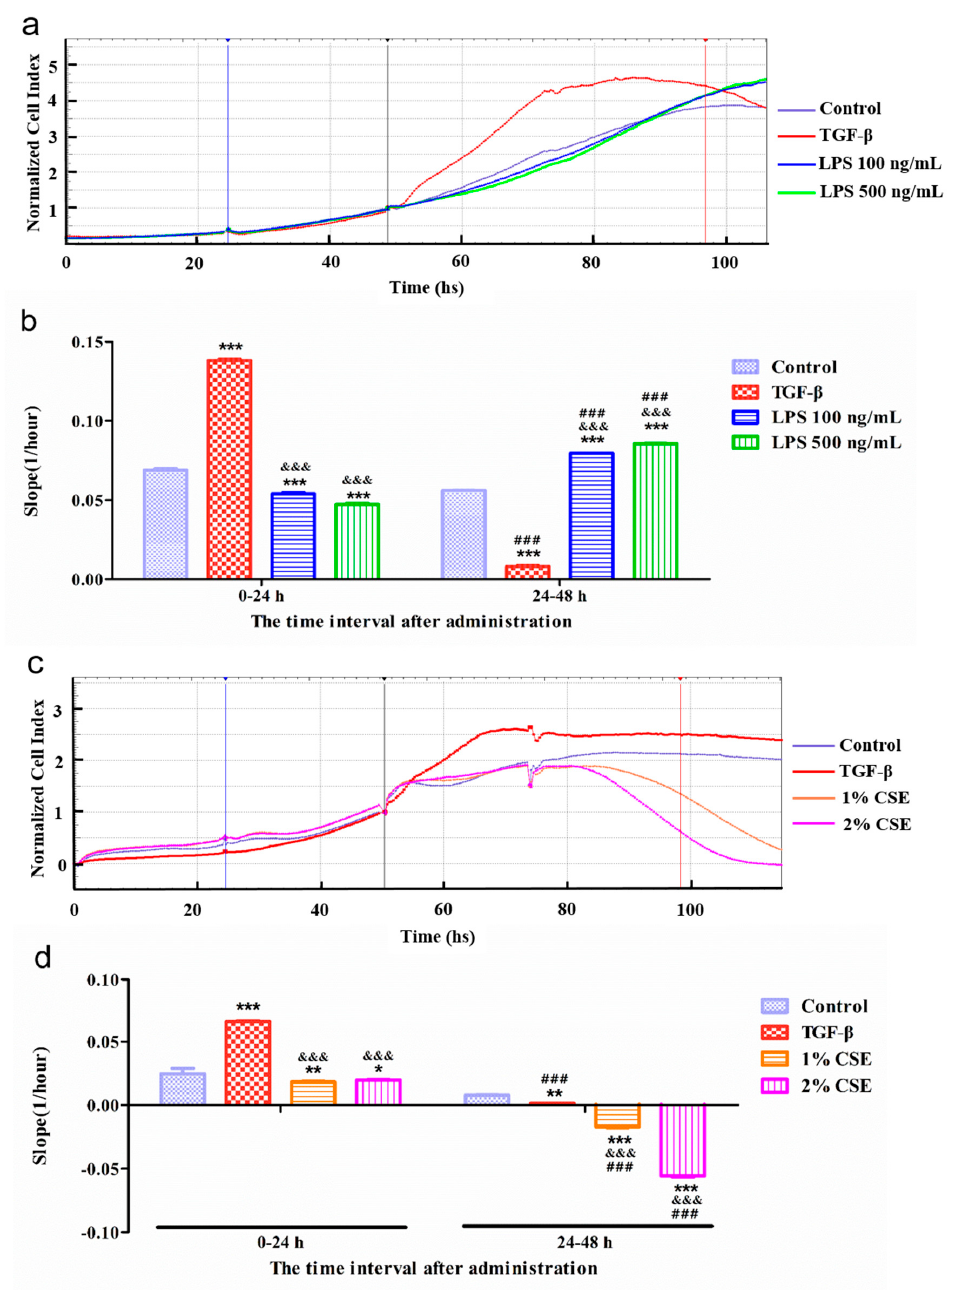
Figure 4. Real-time detection cell index of A549 with di ff erent treatments in the xCELLigence real-time cell analysis (RTCA) single-plate (SP) (RTCA SP) system. ( a ) A549 cells were treated with TGF- β and LPS (100 and 500 ng/mL). The serum starvation step for 24 h starts from the blue vertical line to the black vertical line in the timeline. The time interval between the black and red vertical lines represents administration for 48 h, and the black vertical line is the time to normalize the cell index. Representative curves of the normalized cell index. ( b ) The representative interval slope of the TGF- β and LPS groups. ( c ) A549 cells were treated with TGF- β and CSE (1% and 2%). The conditions were the same as above. ( d ) The representative interval slope of the TGF- β and CSE groups. For the LPS experiment, n = 9; for the CSE experiment, n = 6. *** p < 0.001, ** p < 0.01, * p < 0.05 vs. control group. ### p < 0.01 24–48 h groups vs. 0–24 h groups. &&& p < 0.001 vs. TGF- β group in di ff erent time